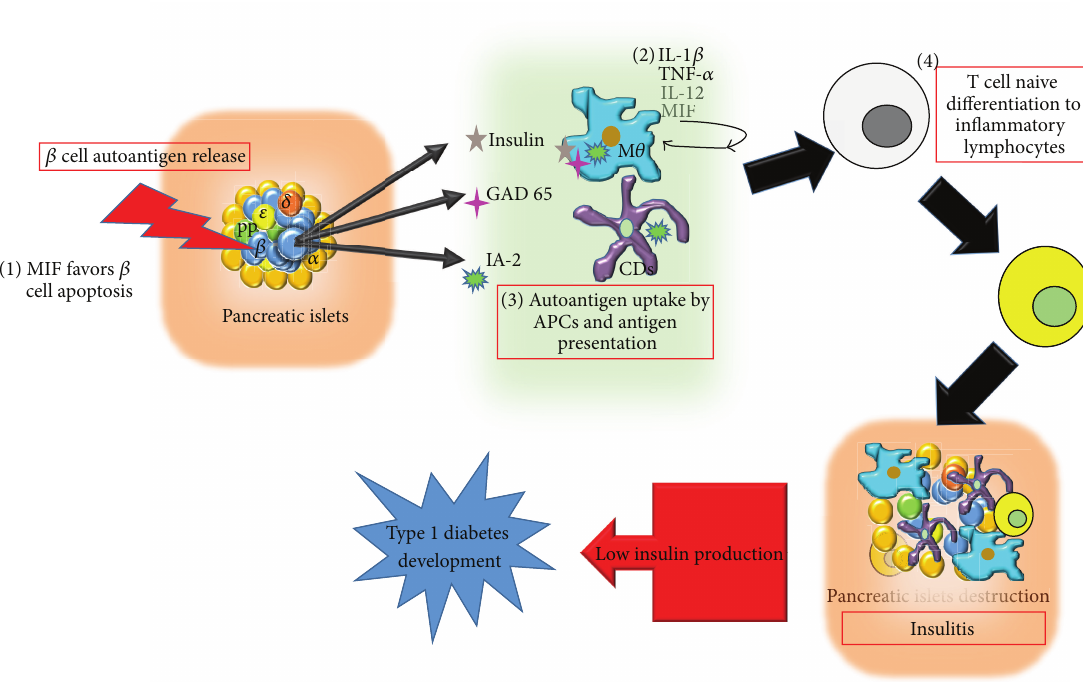
Figure 2: MIF involvement in T1DM development. (1) MIF promotes pancreatic 𝛽 cell apoptosis. (2) MIF promotes the production of inflammatory cytokines such as IL-1 𝛽 , TNF- 𝛼 , and IL-12. (3) MIF favors autoantigen presentation. (4) MIF promotes the activation of an inflammatory response, leading to insulitis.